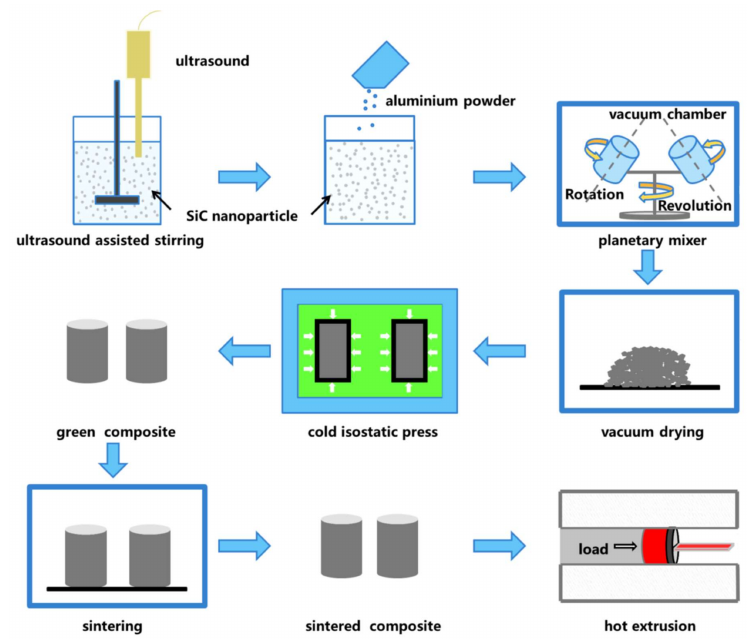
Figure 1. Schematic illustration of preparation process.